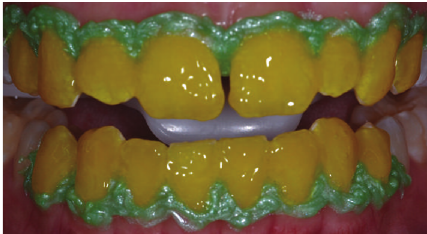
Figure 3: Bleaching gel applied to the buccal surface of the upper and lower teeth.